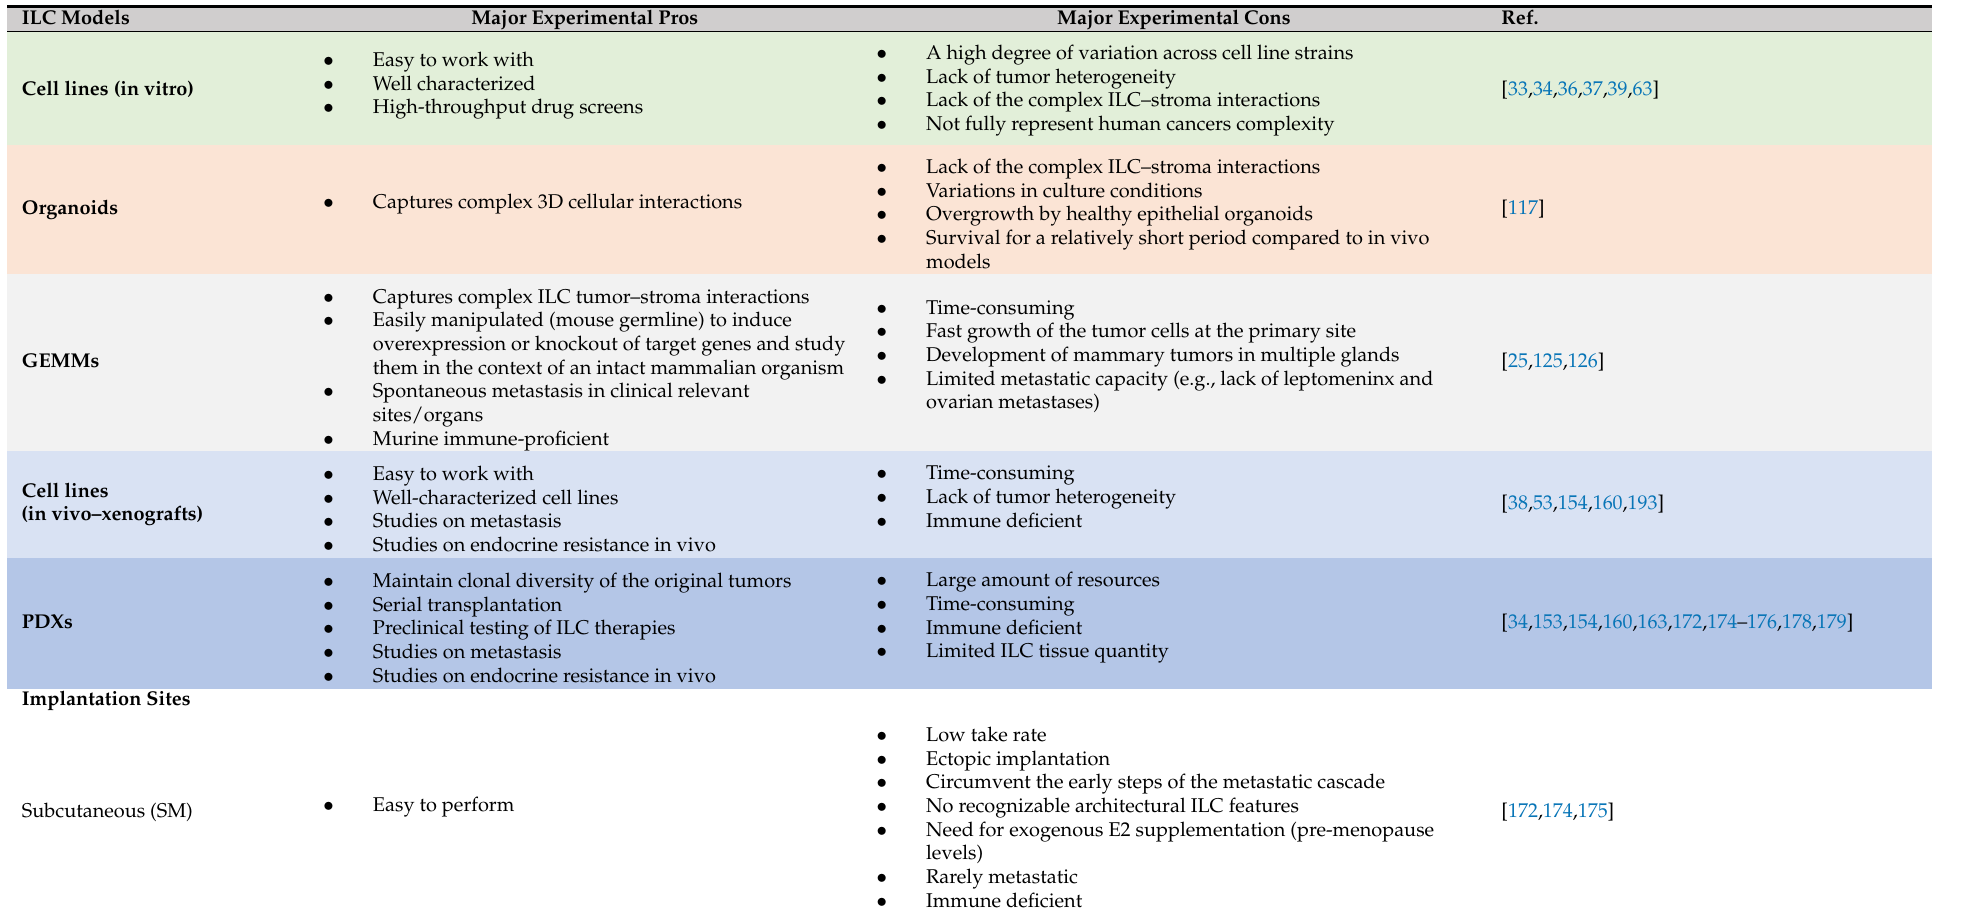
Table 6. Experimental ILC models. Abbreviations: SM, spontaneous metastasis; EM, experimental metastasis; GEMMs, genetically engineered mouse models; PDXs, Patient-derived xenografts; E2, estradiol. Color code: green, cell lines; orange, organoids; grey, GEMMs; purple, xenografts, and PDXs; white, implantation sites. ILC